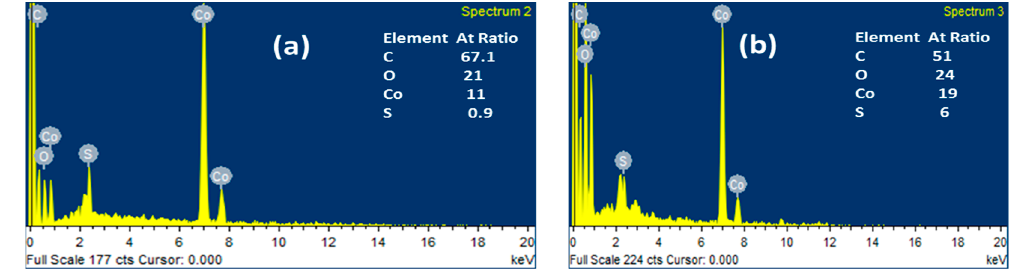
Figure 3. EDS spectrum of ( a ) NPC/CS (H2O) and ( b ) NPC/CS (MeOH).